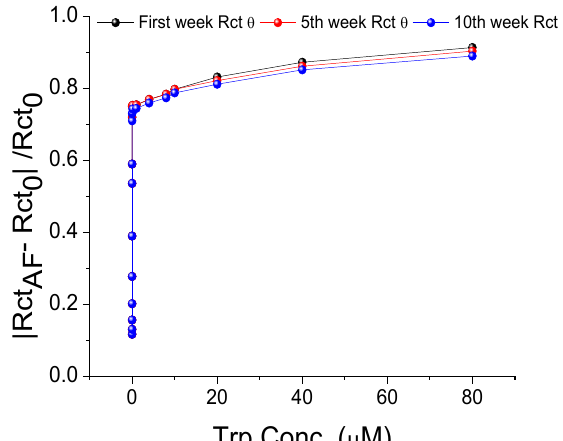
Figure 6. Storage stability of MIP-AF-modified SPEs at room temperature for 10 weeks.